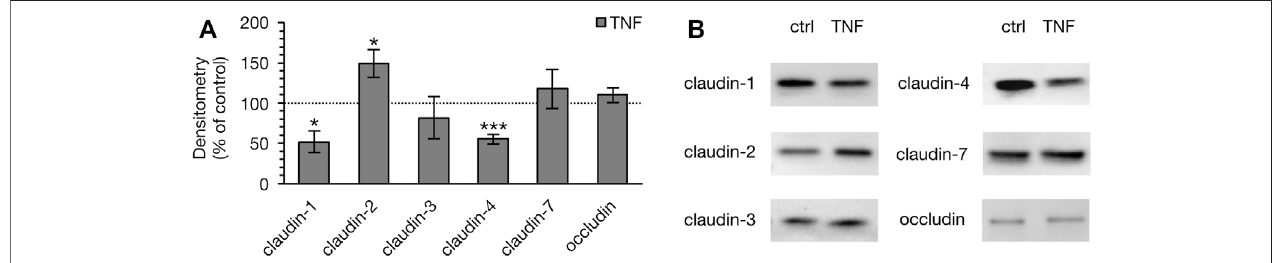
FIGURE 5 | Densitometry (A) and representative Western blots (B) of TJ proteins in PP tissue after 10 h of incubation with 5000 U/ml TNF. A marked lower expression ofclaudin-1and-4wasobserved,whereastheexpressionofclaudin-2wasstronger( n =4 – 6,* p < 0.05,*** p < 0.001).Thedottedlineindicatesthecontrols, which were set to 100% and compared to the TNF treated groups, respectively.